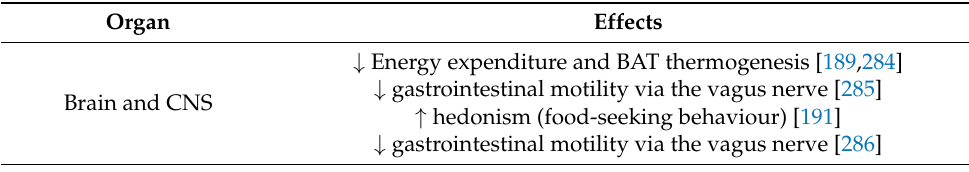
Table 5. Summary of the major effects of eCB system on peripheral tissues. The eCB system promotes the conservation and intake of energy by targeting key cellular mechanisms in adipose tissues. It also acts on several metabolically active organs to control glucose and lipid metabolism. Organ Effects ↓ Energy expenditure and BAT thermogenesis [189,284] ↓ gastrointestinal motility via the vagus nerve [285] Brain and CNS ↑ hedonism (food-seeking behaviour) [191] ↓ gastrointestinal motility via the vagus nerve [286] ↑ ghrelin secretion [287] ↓ motility [286,288] ↑ nutrient absorption with fat preference and intake [289] ↑ insulin secretion by the pancreas [141] Gastrointestinal tract ↑ lipogenesis by the liver [290] ↓ insulin clearance via PI3-kinase and calcium dependent mechanism [291,292] ↓ leptin secretion [195] ↓ lipolysis [273] White adipose tissue ↑ storage capacity: ↑ adipogenesis and ↓ preadipocytes [263] Brown adipose tissue ↓ thermogenesis [189] ↓ glucose uptake [293] Skeletal muscle ↓ insulin signalling